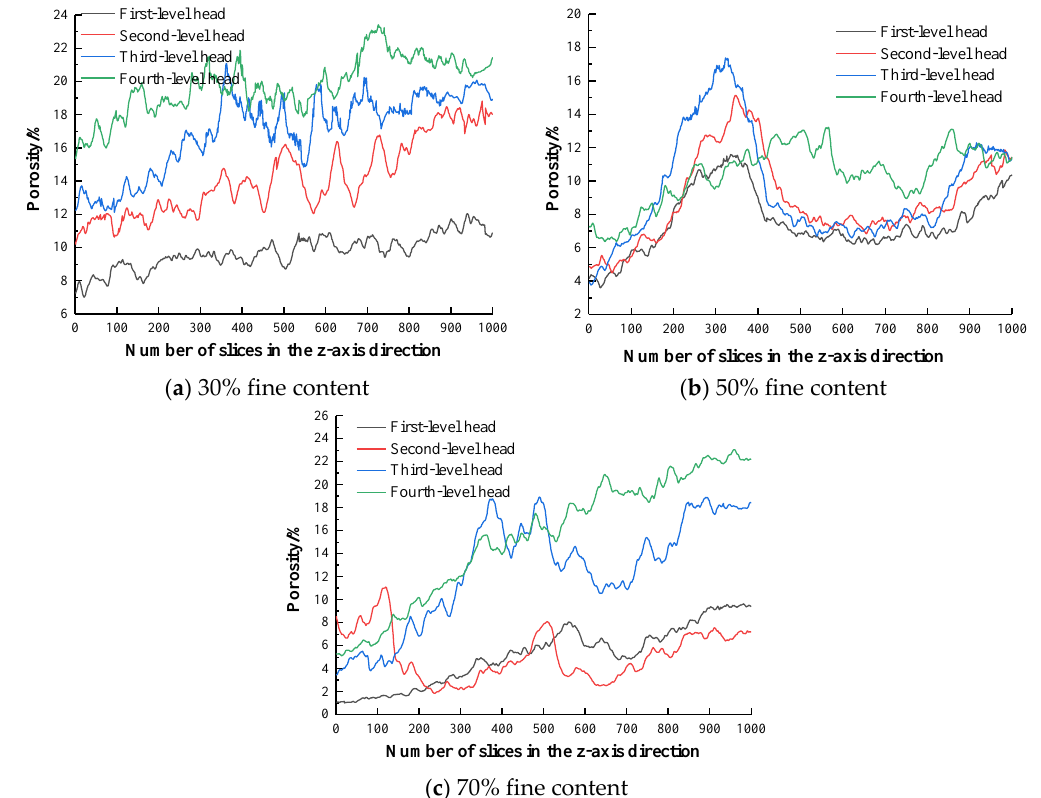
Figure 12. Layer-by-layer porosity statistics of the three fine-grained tailings sand